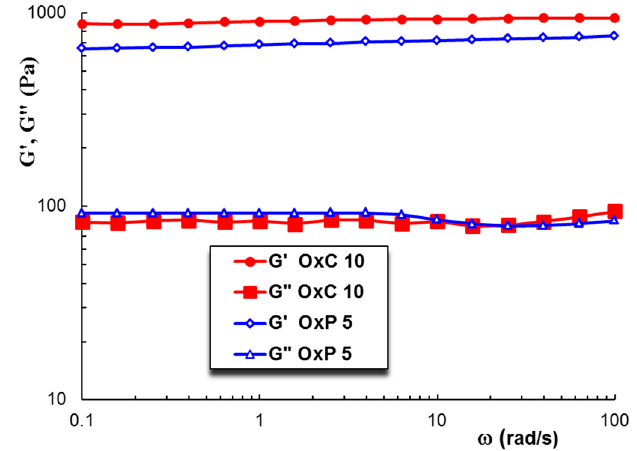
Figure 5. The viscoelastic moduli (G’ and G”) as a function of the oscillation frequency for hydrogels with 10% OxC (red full symbols) and 5% OxP (blue open symbols) at 25 °C ( γ = 1%).